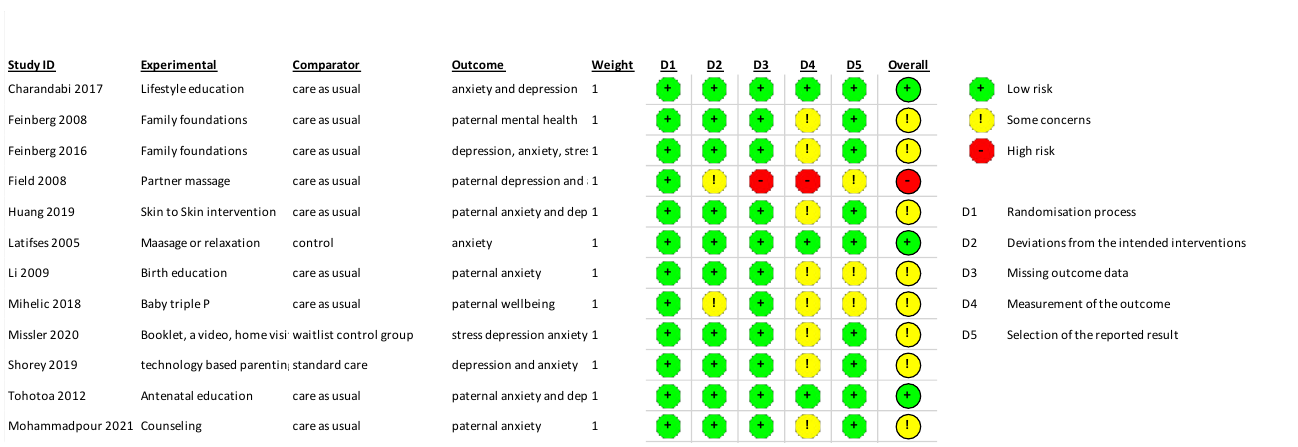
Figure 3. Risk of bias assessments [28,36–46].